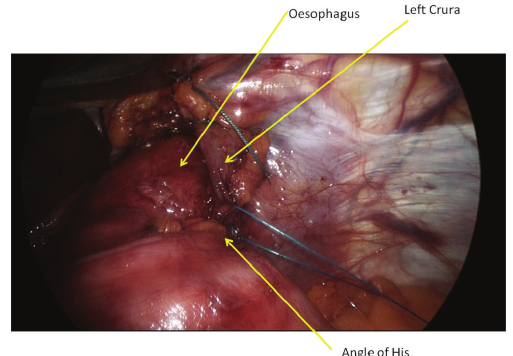
Figure 1: Left sided fixation suture with oesophagus and angle of His anchored to left crura.